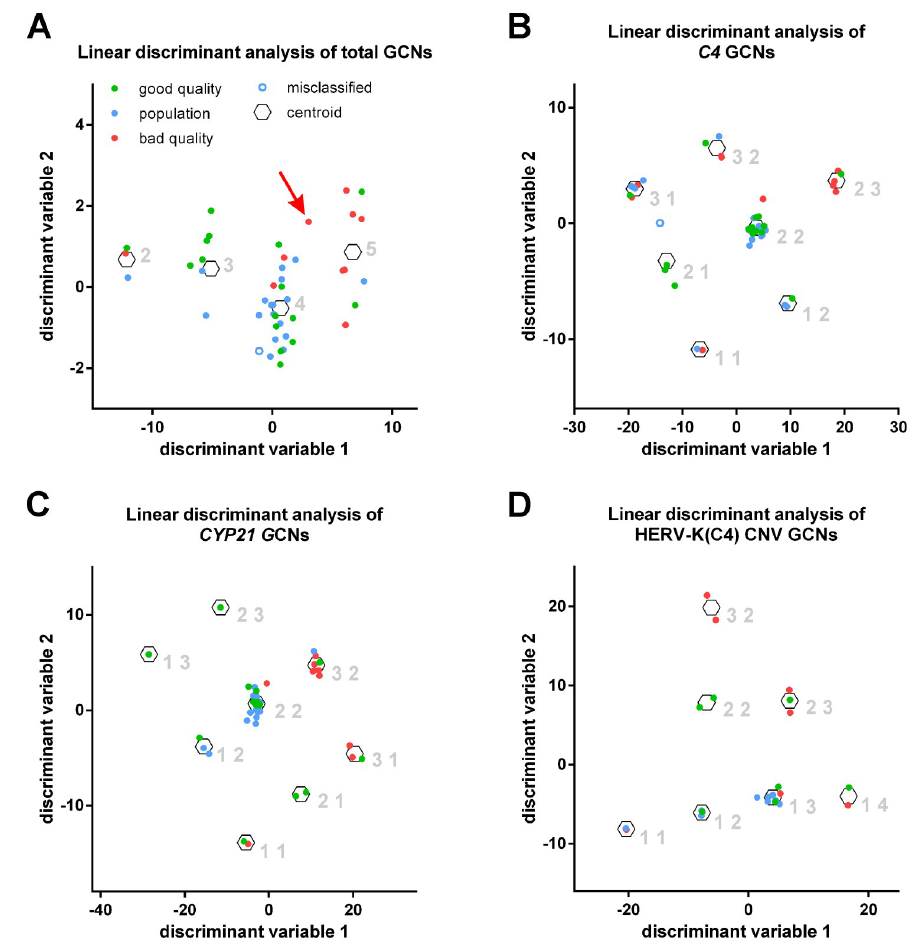
Fig 3. Locations of samples based on discriminant scores generated by linear discriminant analyses (LDA). A .) LDA of total gene copy numbers (GCNs). The GCNs of C4 genes, CYP21 genes, the alleles of HERV-K(C4) CNV and the copy number of RCCX CNV breakpoint + 2 equal each other as well as the copy number of RCCX CNV segment due to genome biology reasons. Grey numbers indicate the total integer GCNs of the particular clusters. B .) LDA of C4 genes. First grey number indicates the integer C4A GCNs of the particular clusters, and the second one indicates the integer C4B GCNs. C .) LDA of CYP21 genes. First grey number indicates the integer CYP21A1P GCNs of the particular clusters, and the second one indicates the integer CYP21A2 GCNs. D .) LDA of the alleles of HERV-K(C4) CNV. First grey number indicates the integer HERV-K(C4) CNV deletion GCNs of the particular clusters, and the second one indicates the integer HERV-K(C4) CNV insertion GCNs. Blue empty circle indicates the NA11839 sample, which was correctly classified for total GCN in spite of its incorrect input class, but its cross-validation of LDA showed a different class for C4 genes. Red arrow indicates the H005 sample, which also received a different class of total GCN by cross-validation than its original class.